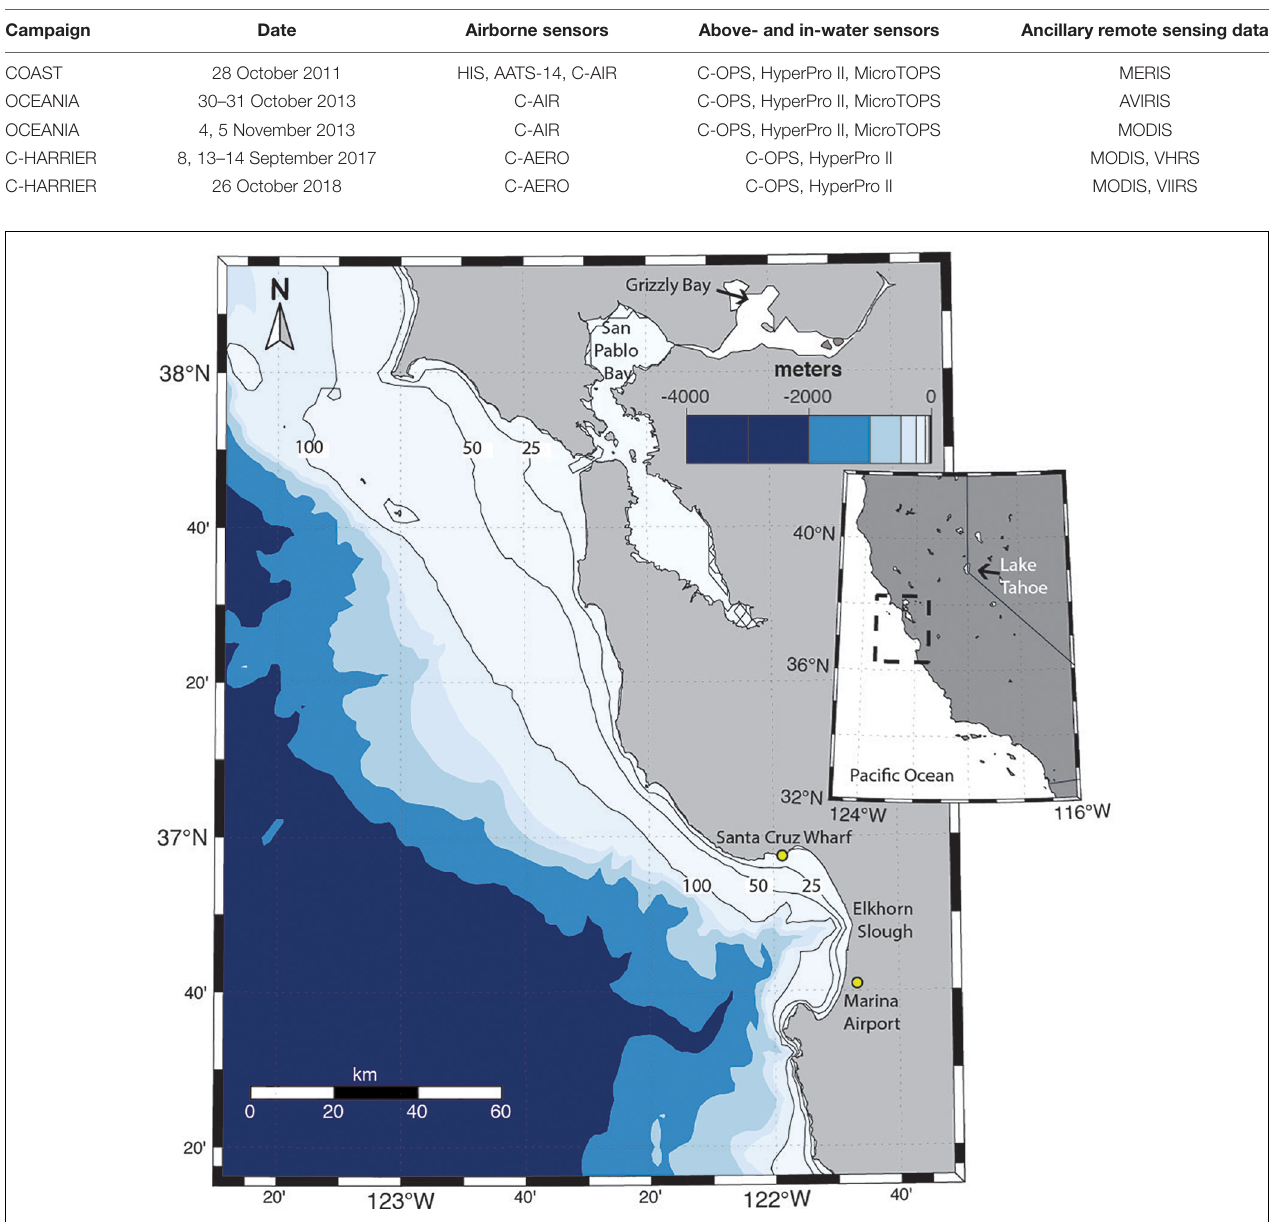
FIGURE 1 | Map of bathymetry and California study site locations of Monterey Bay including Santa Cruz Wharf and Elkhorn Slough, San Pablo Bay, Grizzly Bay, and Lake Tahoe (inset map). The nearby Marina Airport is also identified where the NPS TO is